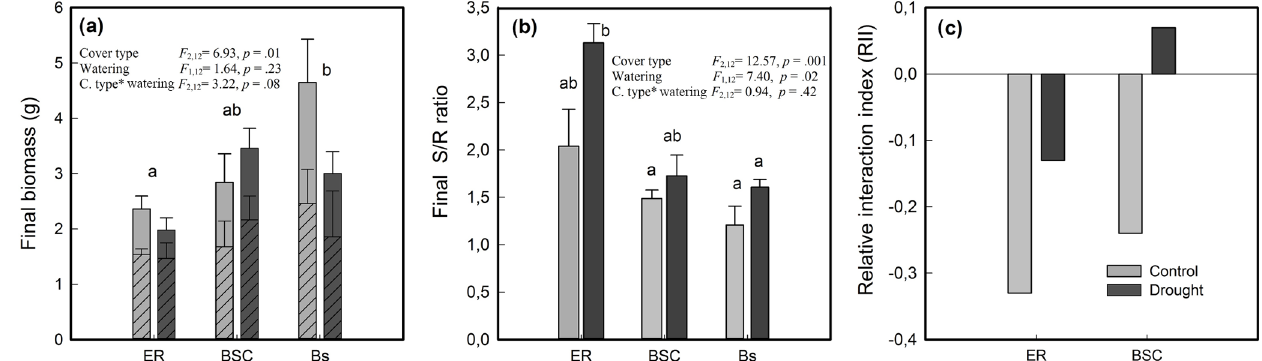
Figure 5. (a) Final biomass (dry weight) of shoot (striped pattern) and root (plain colored), (b) shoot-to-root ratio ( S/R ) and (c) relative interaction index (RII) of Nothofagus pumilio seedlings grown in different cover types and under conditions of full and restricted watering (control and drought, respectively). ER, soil covered by Empetrum rubrum ; BSC, soil covered by biological soil crust; and Bs, bare soil. Biomass and S/R ratio values are means of 3 replicates ± standard error. Significance values ( p ) are from two-way ANOVAs testing effects of soil cover type and watering regime. If main effects or interactions were significant individual comparisons are not shown. Different lower-case letters indicate significantly different values by a posteriori tests at ( p ≤ 0 . 05) for interaction, or ( p ≤ 0 . 003) for main